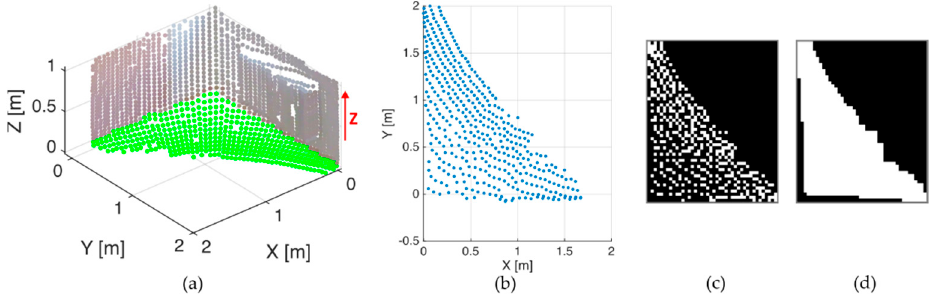
Figure 11. Planar surface detection in Y-axis: ( a ) 1st level selection in the Y-axis; ( b ) Segmented point cloud; ( c ) Resulting level image; ( d ) Morphologically closed and opened image.